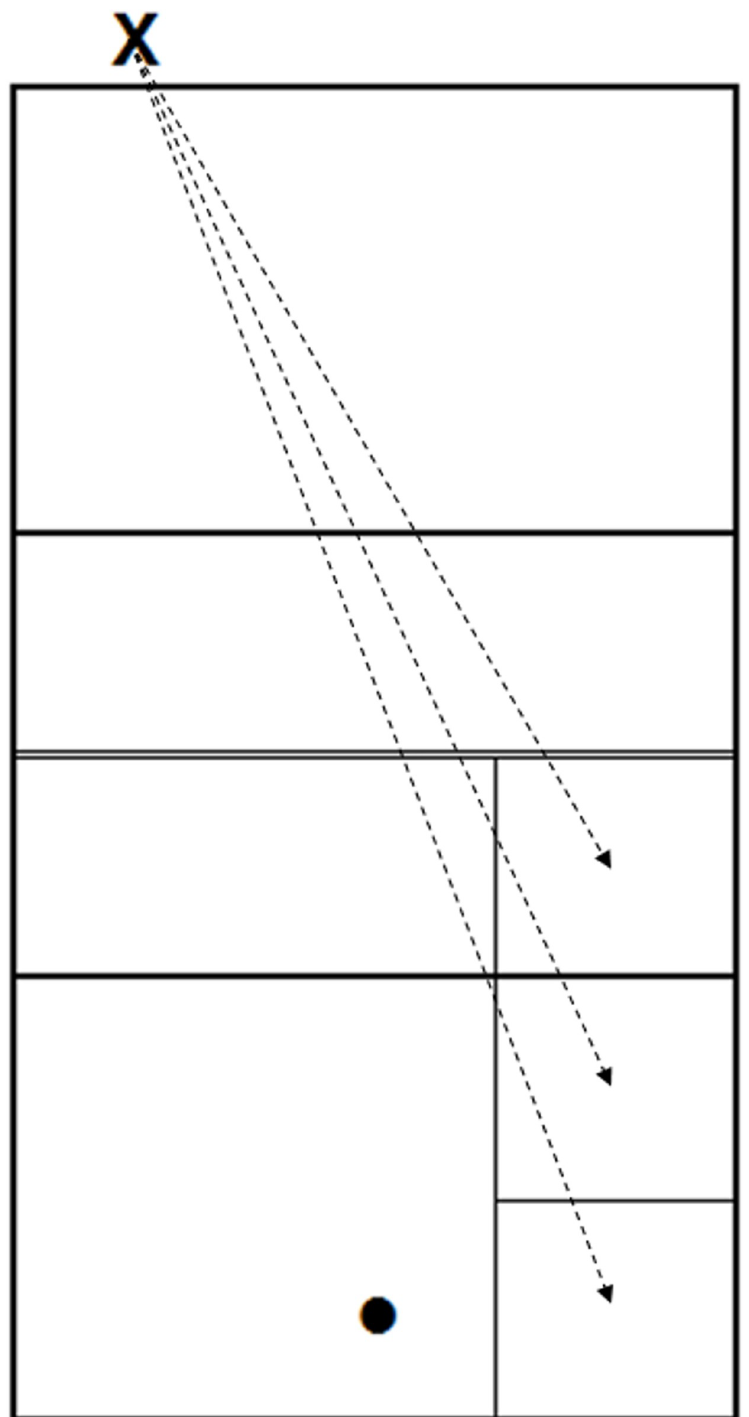
Fig 1. Reproduction of the recording setting. The “X” represents the serving point; the arrows indicate the direction of the serves, and the squares represent the three landing sectors. The dot indicates where the camera and the microphone were